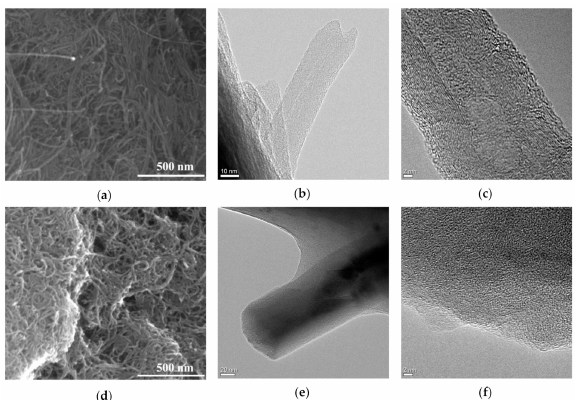
Figure 1. Representative SEM images of ( a ) multi-walled carbon nanotubes (MWCNT); ( d ) chitosan multi-walled carbon nanotubes (CS_MWCNT) and representative high-resolution transmission electron microscopic images of ( b , c ) MWCNT and ( e , f )